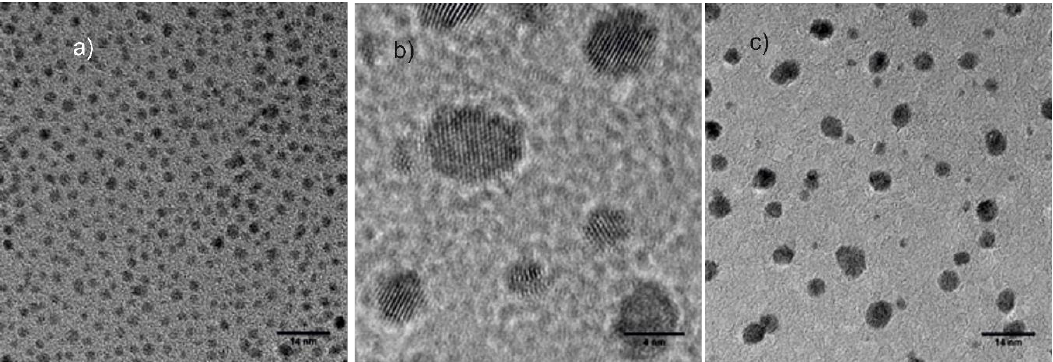
Figure 3. TEM images of ( a ) AuNP tOcBr , ( b ) mixture AuNP tOcBr /ZnPc RS , and ( c ) adduct AuNP tOcBr -S- TEM images of ( a ) AuNP tOcBr , ( b ) mixture AuNP tOcBr / ZnPc RS , and ( c ) adduct ZnPc R . AuNP tOcBr -S-ZnPc R